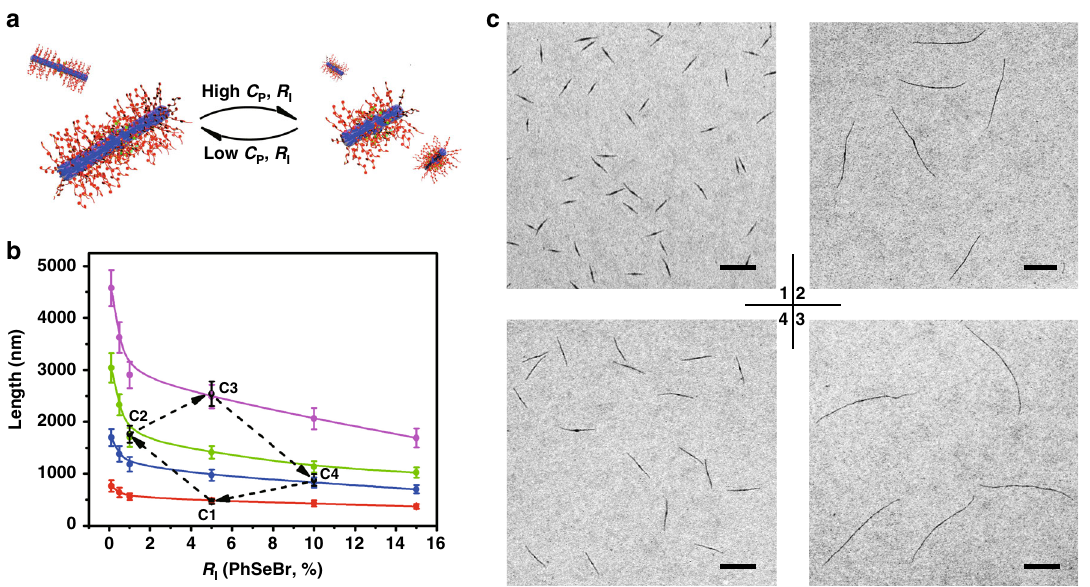
Fig. 2 The reversible assembly initiated by PhSeBr and length control. a Schematic illustrations of the reversible assembly initiated by PhSeBr. b The variation of cylindrical micelle length versus R I with various C P (red, 0.1 mg/mL; blue, 0.05 mg/mL; green, 0.025 mg/mL; pink, 0.0125 mg/mL; black, transition cycle experiment; error bars represent the s.d.). c TEM images of the cylindrical micelles from the transition cycle experiment prepared by heating at 80 °C for 20 min and cooling naturally to 20 °C in 2 h: C 1, C P = 0.1 mg/mL and R I = 5%; C 2, C P = 0.025 mg/mL and R I = 1%; C 3, C P = 0.0125 mg/mL and R I = 5%; C 4, C P = 0.05 mg/mL and R I = 10%. Scale bars are 1 μ